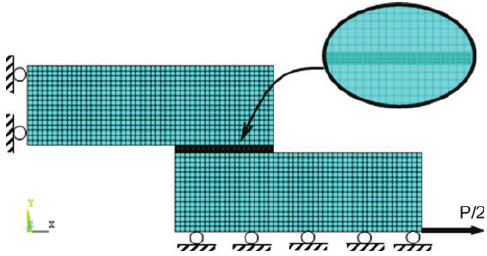
Figure 8 Symbolic modeling and meshing of the double-lap joint.